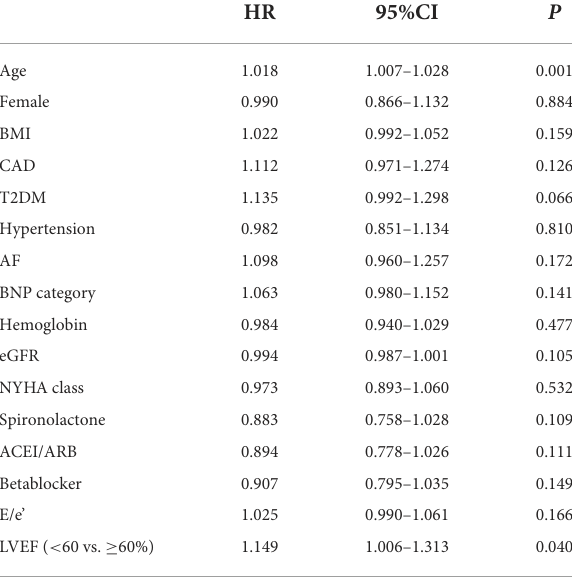
TABLE 3 Multivariable Cox for composite endpoints in total HFpEF